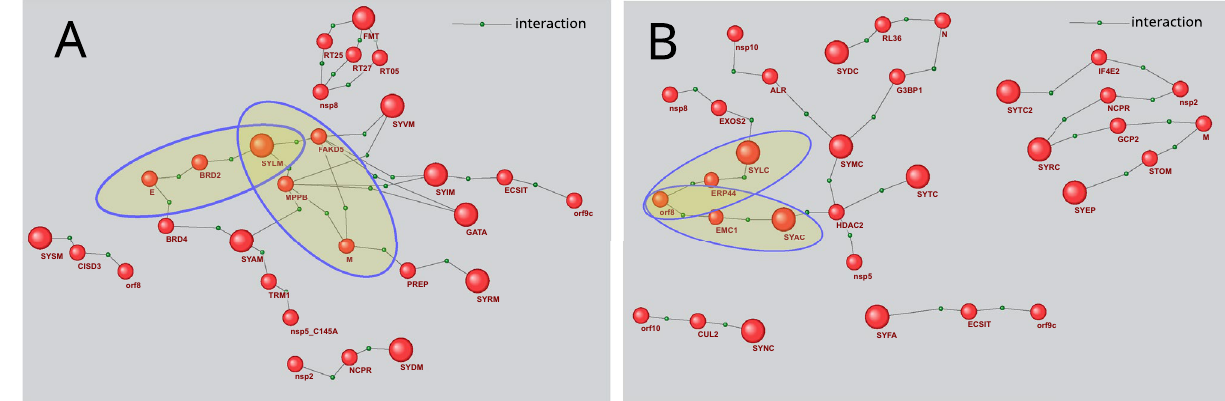
Figure 1. Gene networks describing mitochondrial ( A ) and cytoplasmic ( B ) P 2 pathways, by which the virus, potentially, affects the proteins of aminoacyl-tRNA biosynthesis. The bigger balls show the proteins of aminoacyl-tRNA biosynthesis, while the smaller ones designate other proteins. The pathways discussed in the text are outlined.